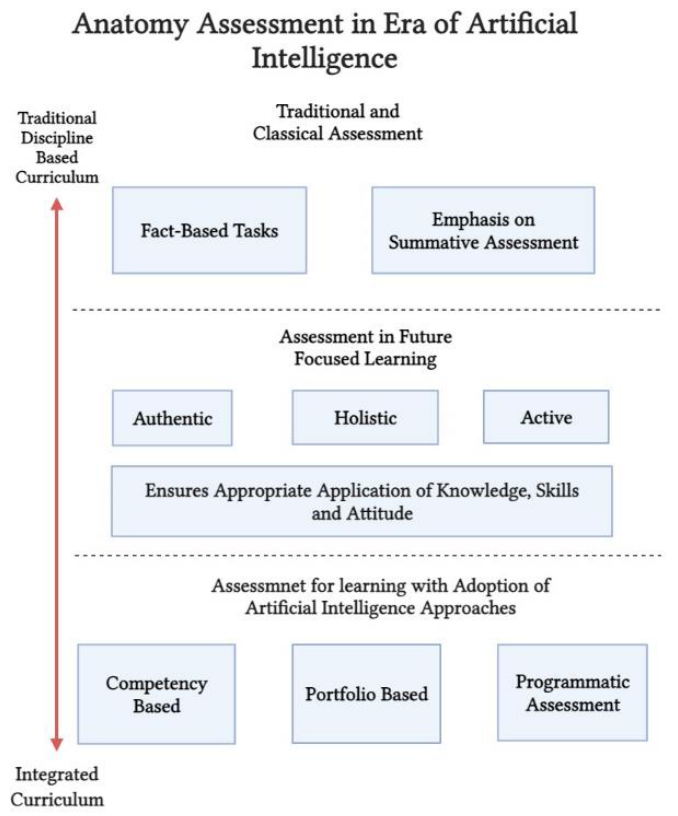
Figure 3. Anatomy assessment in era of artificial intelligence.